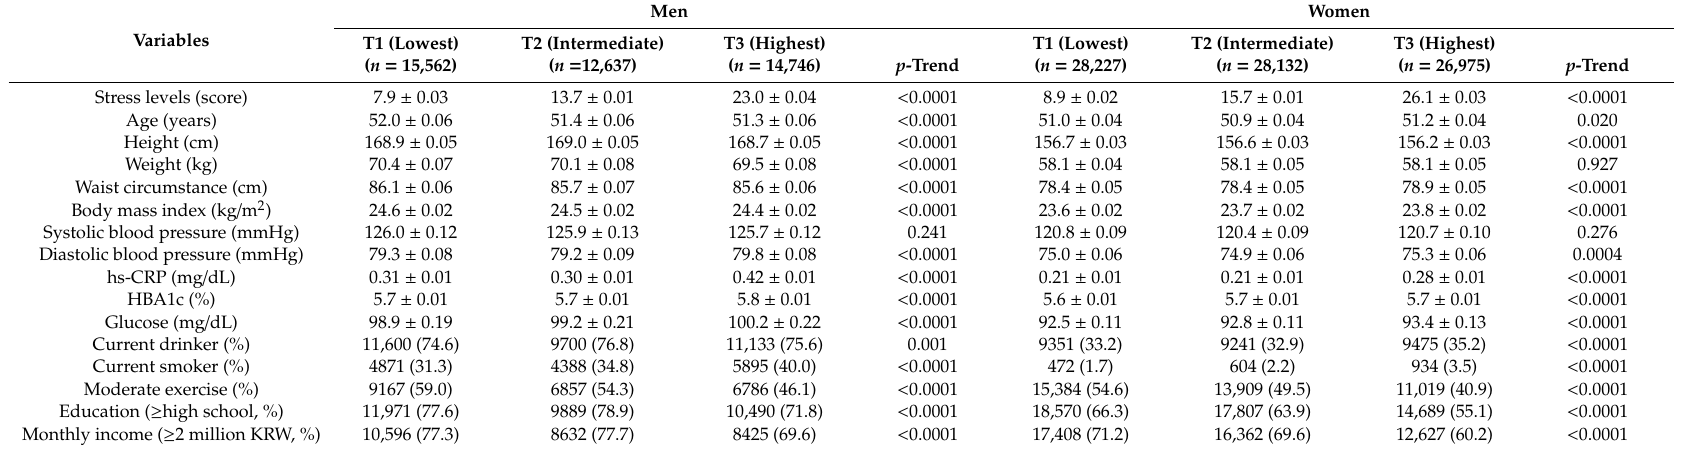
Table 1. General characteristics of the subjects by tertiles of stress levels.